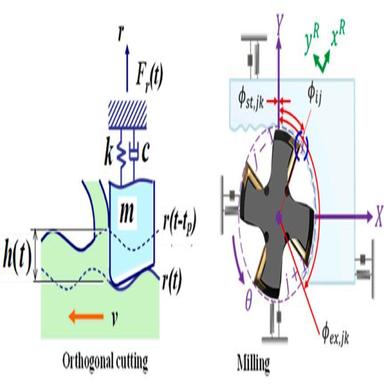
Dynamics of orthogonal cutting and milling.